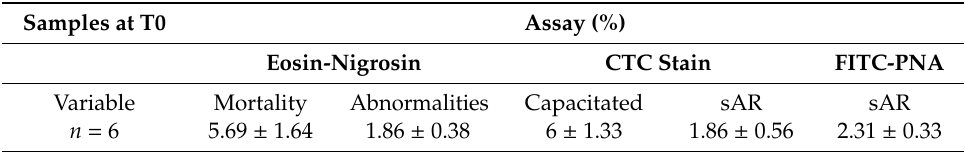
Table 1. Initial sperm evaluation